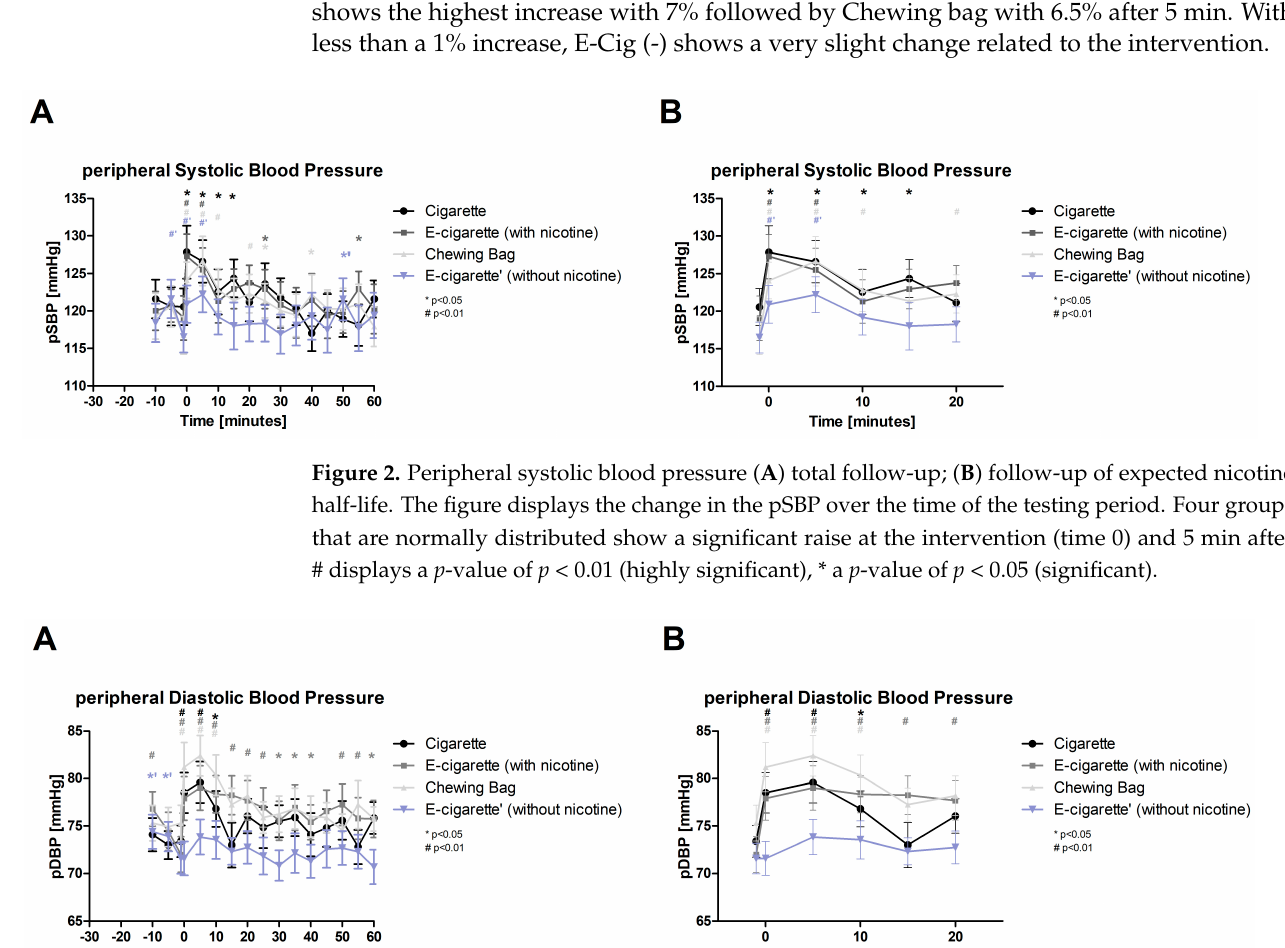
(+) stay elevated significantly for 20 min. After a latency of 25 min to the intervention E- Figure 3. Peripheral diastolic blood pressure ( A ) total follow-up; ( B ) follow up of expected nicotine half-life. The figure displays the pDBP over time. At time 0 the intervention is undertaken, which min. With less than a 1% increase, E-Cig (-) shows a very slight change related to the causes the Cig, E-Cig (+) and Chewing bag to raise highly significant (# p < 0.01) over 15 min, Cig at 15 min after with p < 0.01.